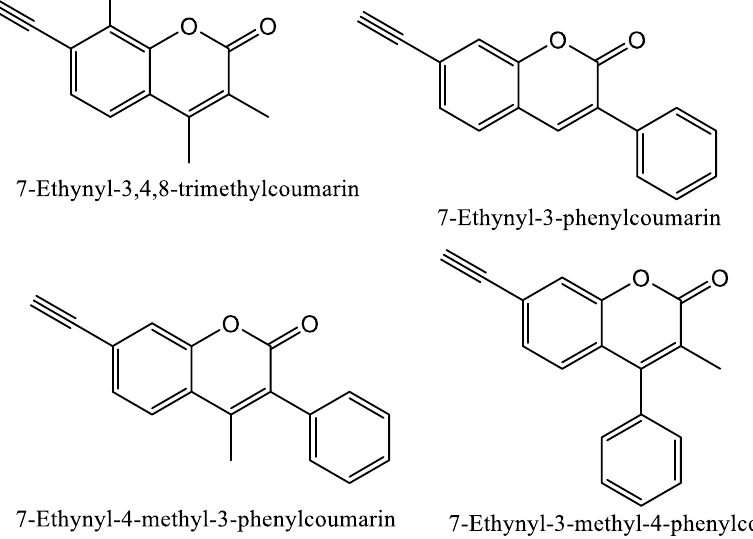
Figure 8. Structure of coumarin mechanism-based inhibitors with selectivity toward P450s 1A1 and 1A2 compared to P450s 2A6 and 2B1 [22].